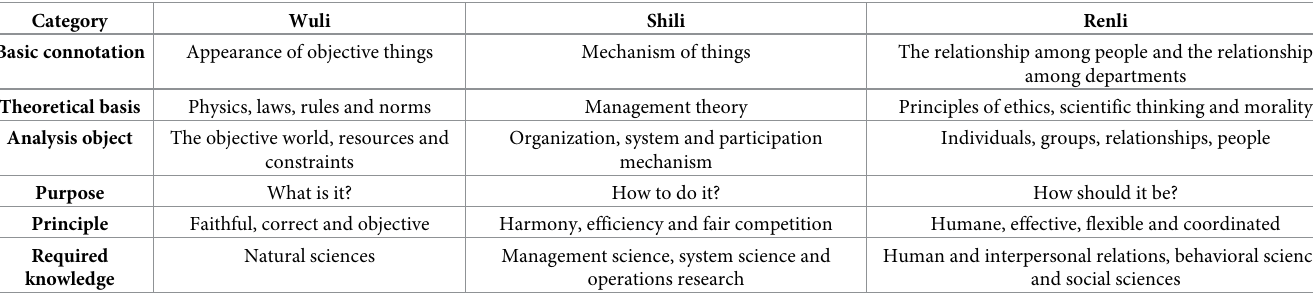
Table 1. The basic ideas of the WSR system